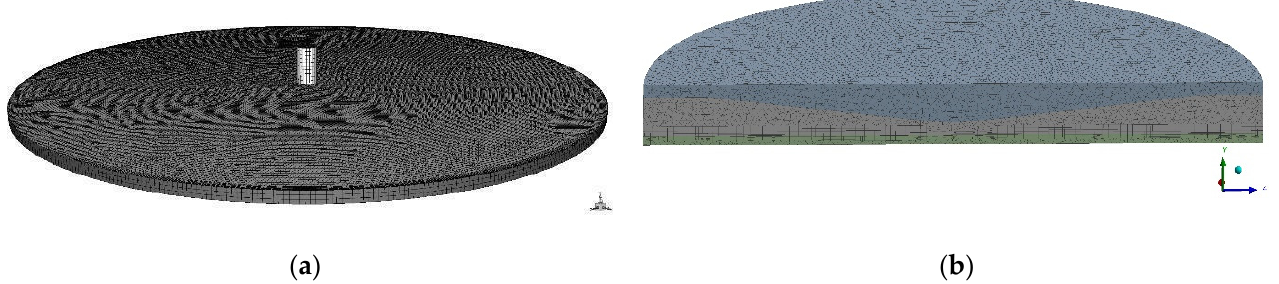
Figure 1. ( a ) FVM meshes of fluid domains of radial flow test; ( b ) FVM meshes of fluid domains of Impact-R test.